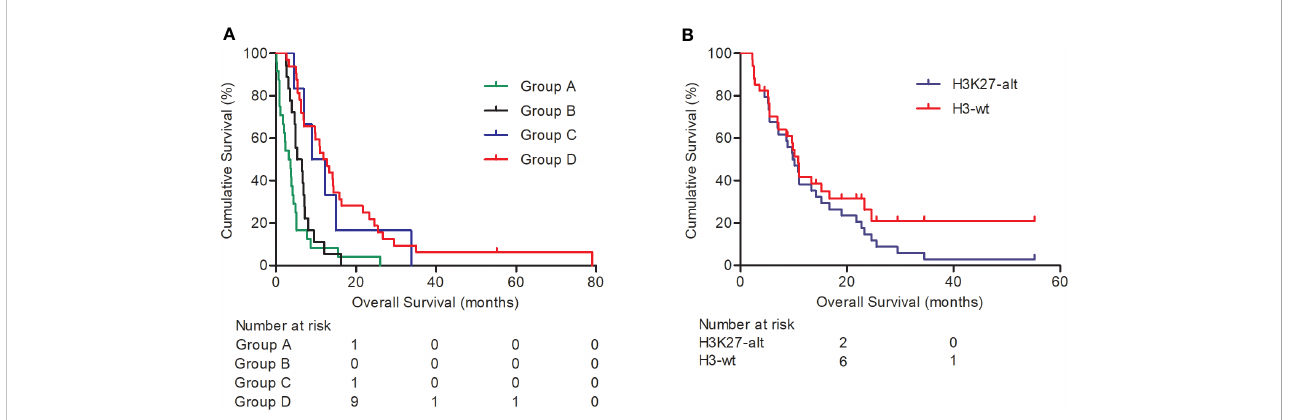
FIGURE 1 Kaplan – Meier survival analysis for DIPGs. Graph (A) shows the overall survival of DIPG patients in different treatment groups: Group A, clinical observation group; group B, stereotactic biopsy or open cranial surgery; group C, stereotactic biopsy plus radiotherapy and/or chemotherapy; group D, open cranial cytoreductive surgery plus radiotherapy and/or chemotherapy. Graph (B) indicates H3K27 alteration status predicts shorter overall survival ( P = 0.004).